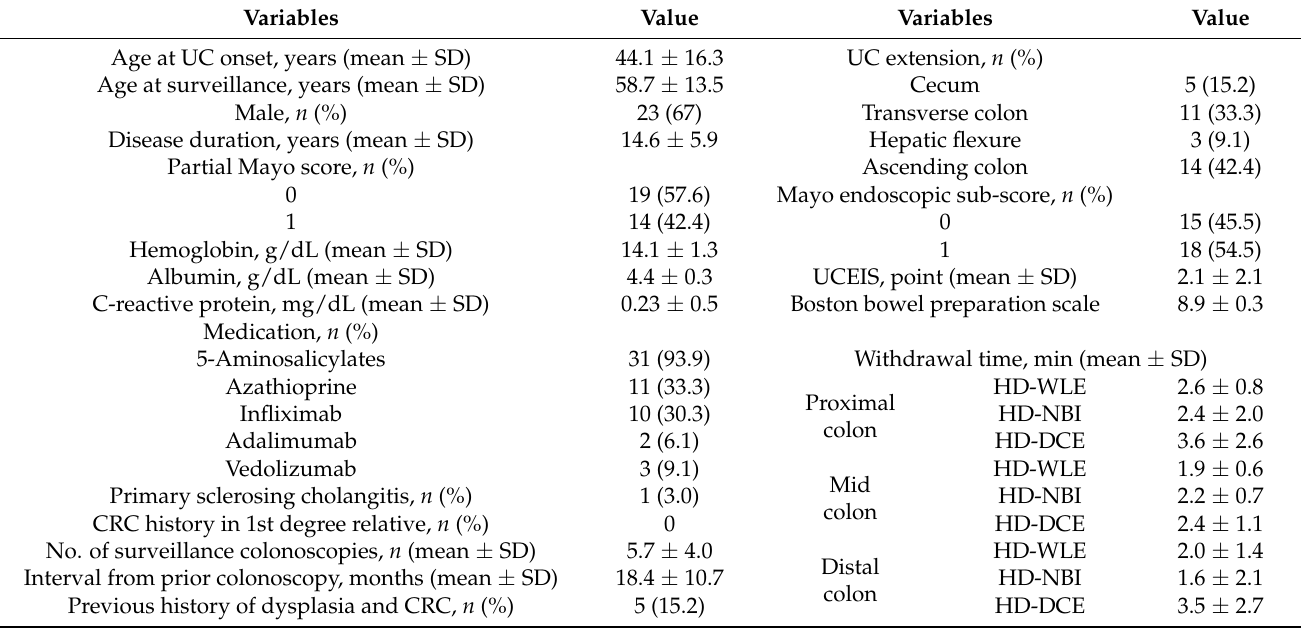
Table 1. Baseline characteristics of study